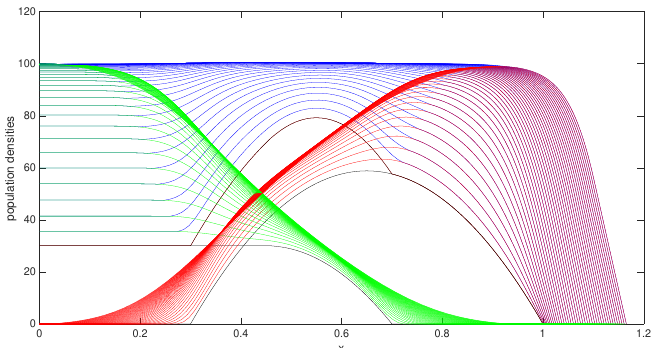
Figure 2. Result of the competition–diffusion model at t = 10. Here, we use δ 1 = δ 2 = 0.001, K 1 = K 2 = 1, k 1 = k 2 = 100, r 1 = r 2 = 1, and µ = 50. Both species have reached their maximum carrying capacities ( k 1 and k 2 ) and diffuse in the domain through the moving